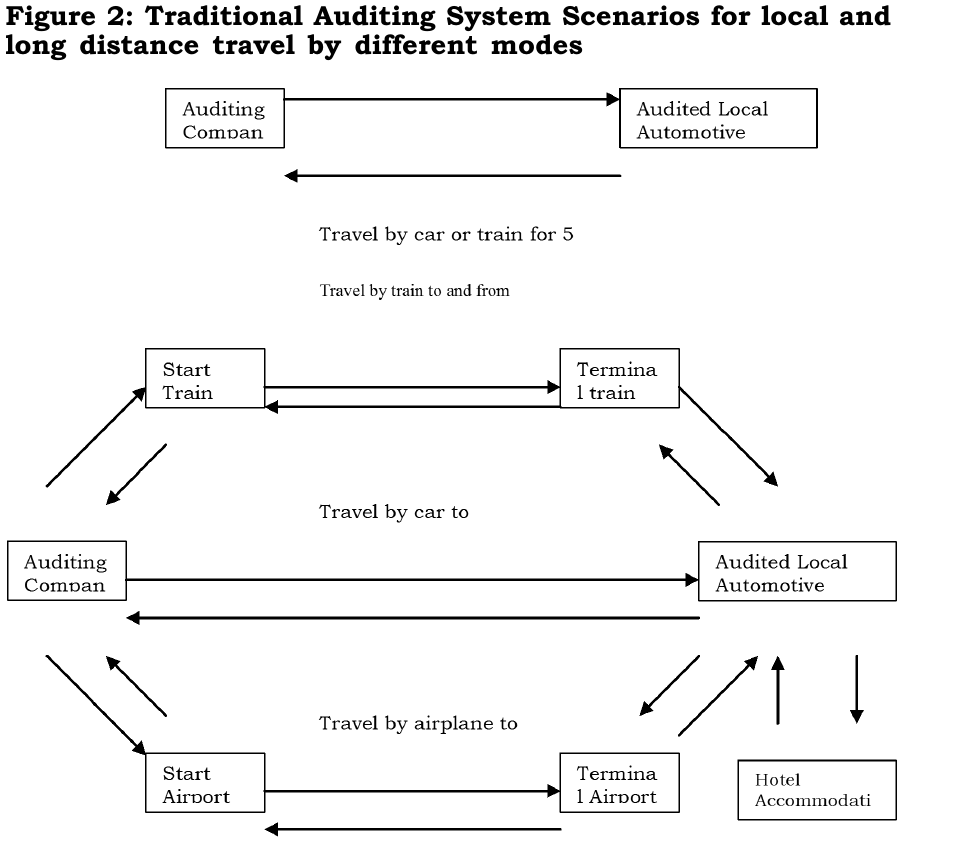
Figure 2: Traditional Auditing System Scenarios for local and long distance travel by different